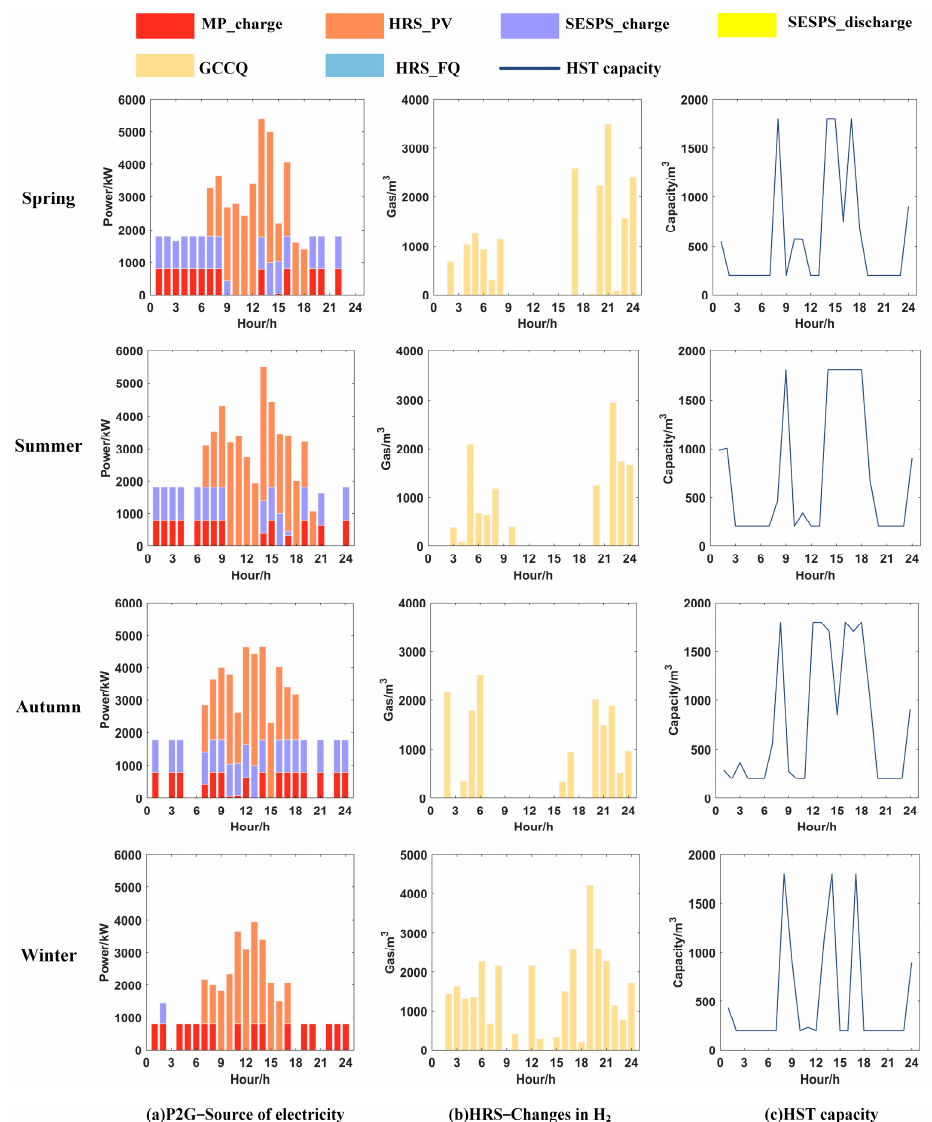
Figure 11. HRS optimization results − Scenario 7.